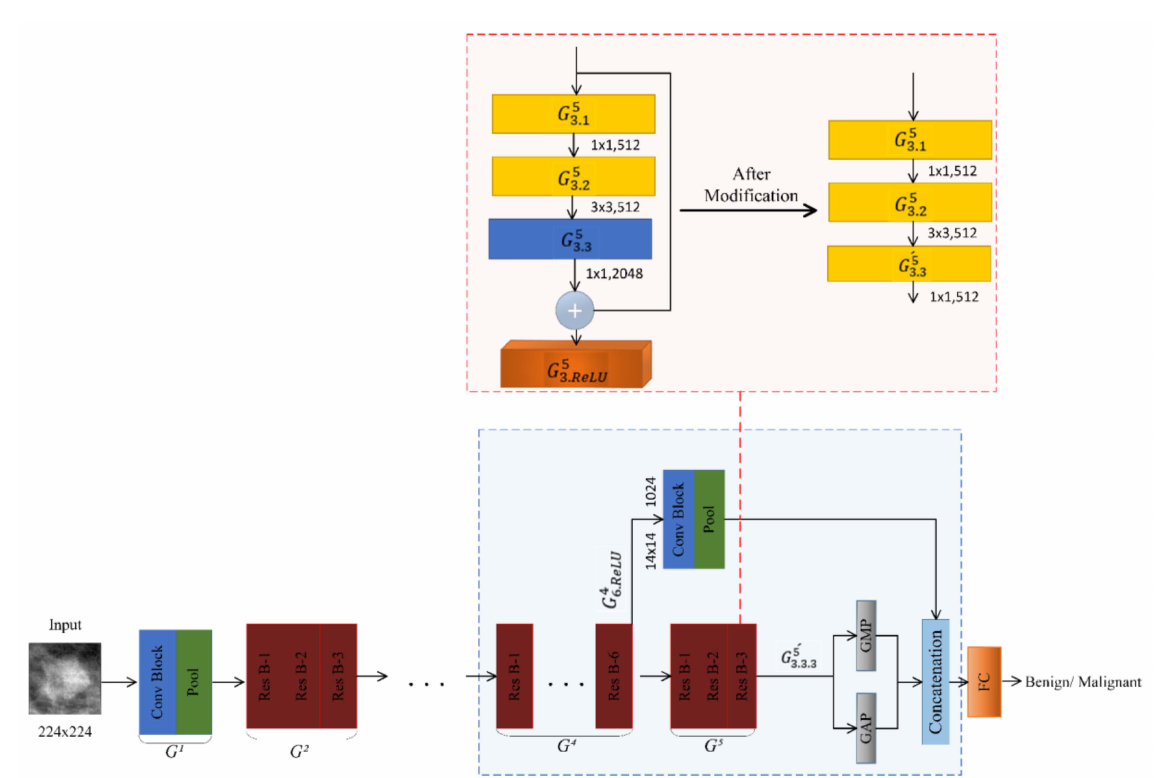
Figure 8. DIIIResNet-50